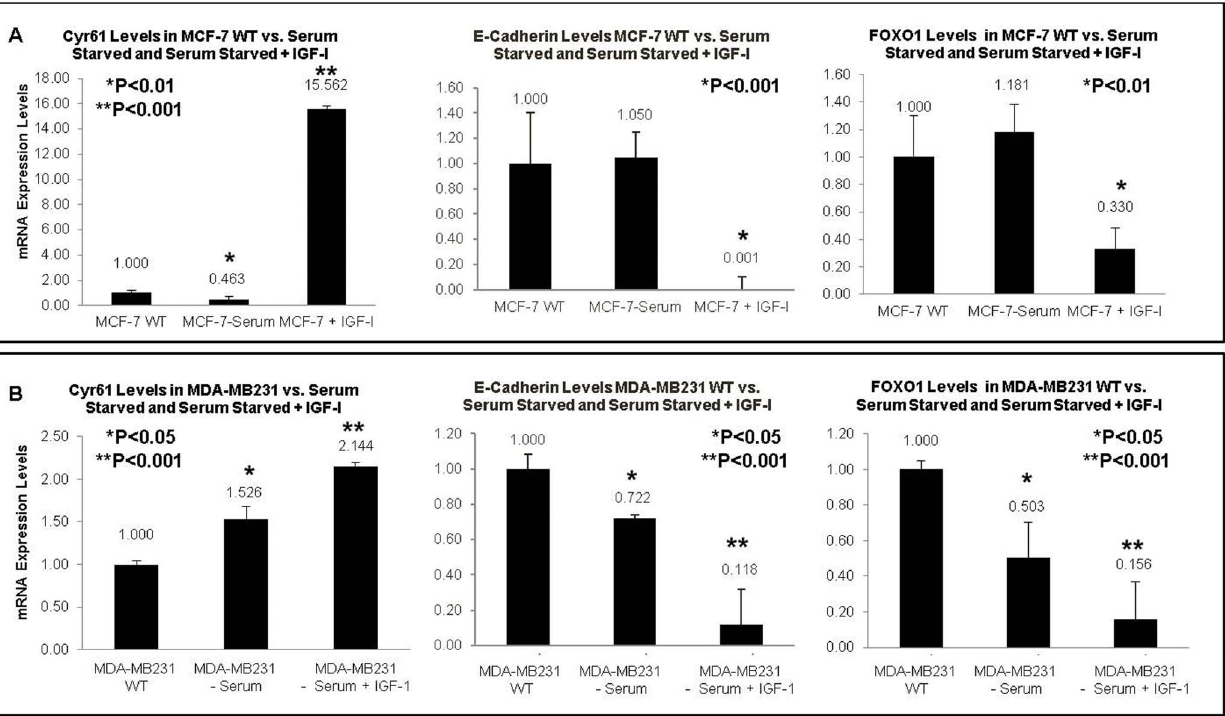
Figure 5. Inverse Relationship between IGF-1 induced Cyr61 upregulation and decreased E-cadherin and FOXO1 expression is confirmed in two cell lines. The mRNA expression of Cyr61, E-cadherin, and FOXO1 were assessed by RT-Q-PCR. All mRNA levels were adjusted for the housekeeping gene, 18S. ( A ) Expression of Cyr61, E-cadherin, and FOXO1 in response to IGF-1 induction (100 ng/mL) following serum starvation in MCF-7 WT cells; and ( B ) MDAMB231 cells. P-values were assessed relative to the untreated condition within each cell line, and P , 0.05 considered statistically significant.